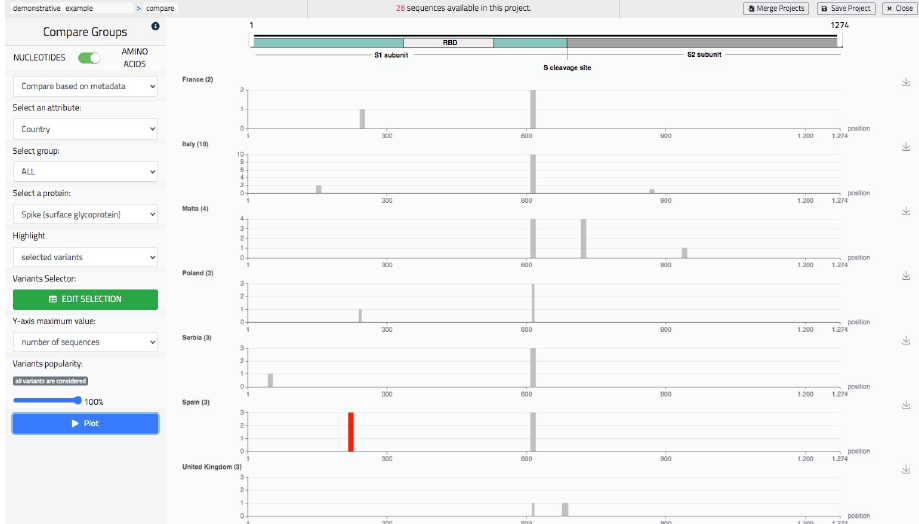
Figure 8. The ‘Compare’ screen of VirusLab, a comparative representation of the variants’ distribu- tions in different groups of the observed